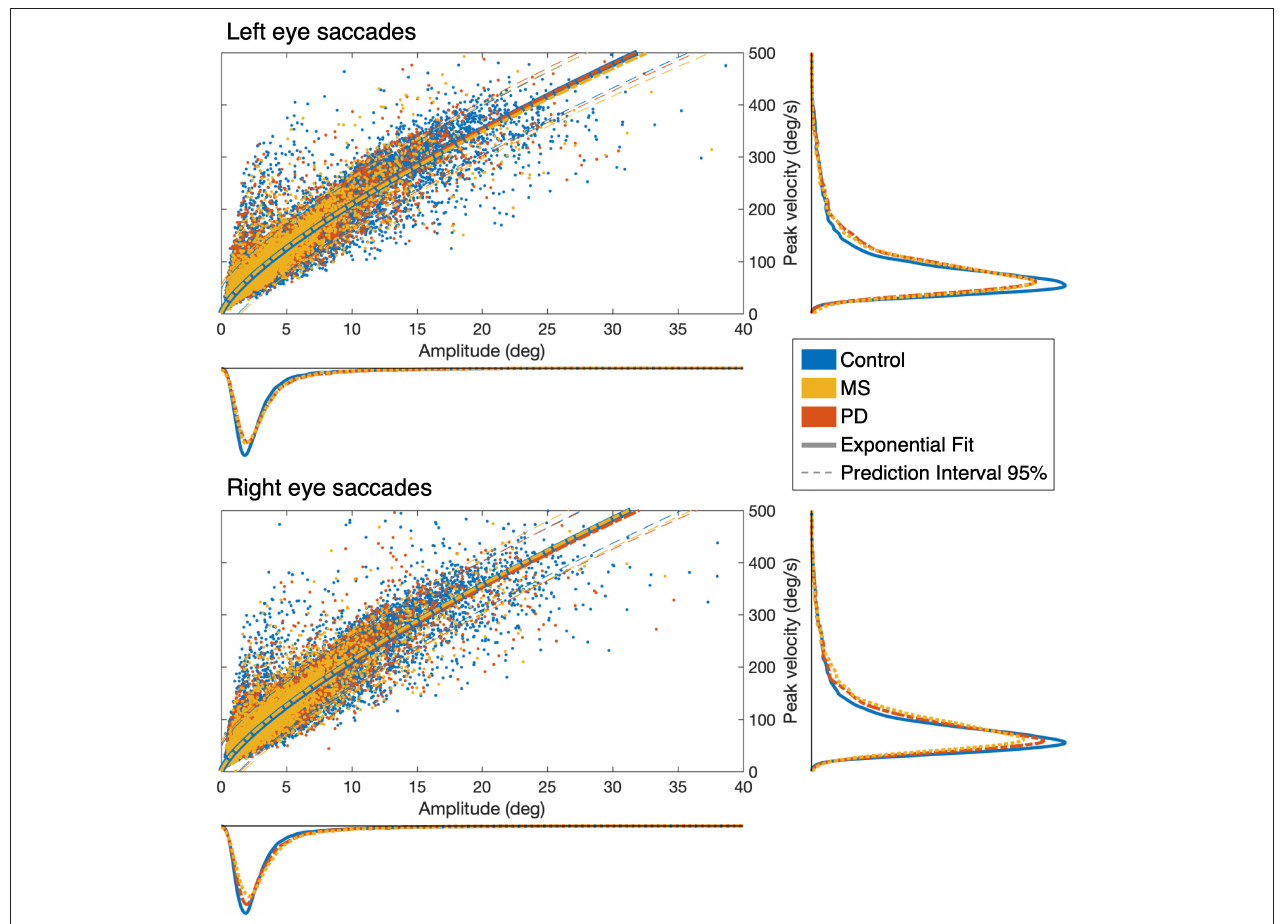
FIGURE 2 | Saccadic main-sequences in the three examined groups of observers. The individual saccades (scatter plot) display the classic exponential relationship between amplitude and peak velocity, with no statistically significant differences between Control, MS, and PD groups: all 95% prediction intervals overlap with each other. Also when taken separately (marginal histograms), the amplitude and peak velocity distributions do not differ between groups or between